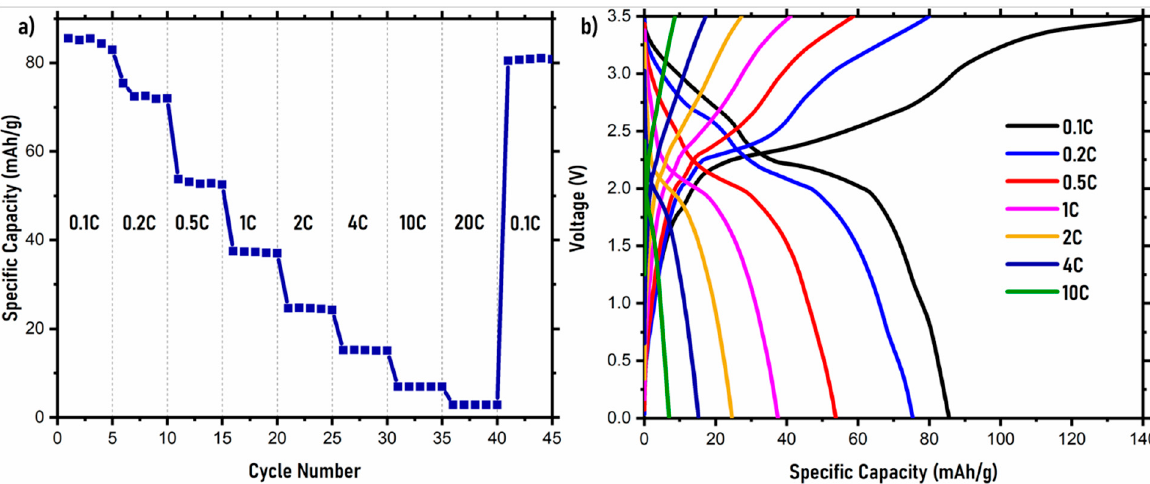
Figure 3. ( a ) Rate capability of NVPF symmetric cell and its corresponding ( b ) charge–discharge curves at different C rates. The cycling performance of the symmetric NVPF symmetric cells was tested in the voltage range of 0–3.5 V at both 0.1 C and 1 C. Figure 4 shows the entire cycling performance for both the cells and their respective galvanostatic charge–discharge cycles. At 1 C, the symmetric cell delivers an initial discharge capacity of ~64 mAh/g. The discharge capacity decreases to ~39 mAh/g after 1000 cycles. This corresponds to a capacity retention of 61%. Throughout the cycling process, there exists regions where the cell overcompensates for a lack of deficiency in the cathode, resulting in fluctuating discharge capacity values. This is also observed from the columbic efficiency curves, which average about 98%. Figure 4b shows the galvanostatic charge–discharge curves of the symmetric cell with a 1 C rate at the 1st, 250th, 500th, 750th, and 1000th cycles. The initial cycle is seen as irreversible as a charge capacity of 110 mAh/g is observed. The two plateaus observed in the charge curve in the first cycle are similar to that of the RC curve in Figure 3b, which corresponds to the Na intercalation from Na (1) and Na (2) sites into the anode [42]. However, this phenomenon is only observed in the first cycle. For the following cycles, no distinct plateaus can be observed and, through the 1000 cycles, a distinct capacity fade is observed. The cycling performance and its 1st, 5th, 10th, and 15th galvanostatic charge—discharge capacity curves at 0.1 C is shown in Figure 4c,d. Here, an initial discharge capacity of 85 mAh/g is shown by the symmetric NVPF cell and a coulombic efficiency of ~90%. There is a slight capacity fade observed and the capacity retention of the symmetric cell after 20 cycles is ~92%. The galvanostatic charge–discharge curves show two clear plateaus corresponding to Na (de)intercalation. In the first cycle, once again, a slight irre- versible charge capacity curve is seen. Comparatively, throughout the rest of the cycles, the capacity fade is low, mainly due to the slow C rate at which the cell is running.